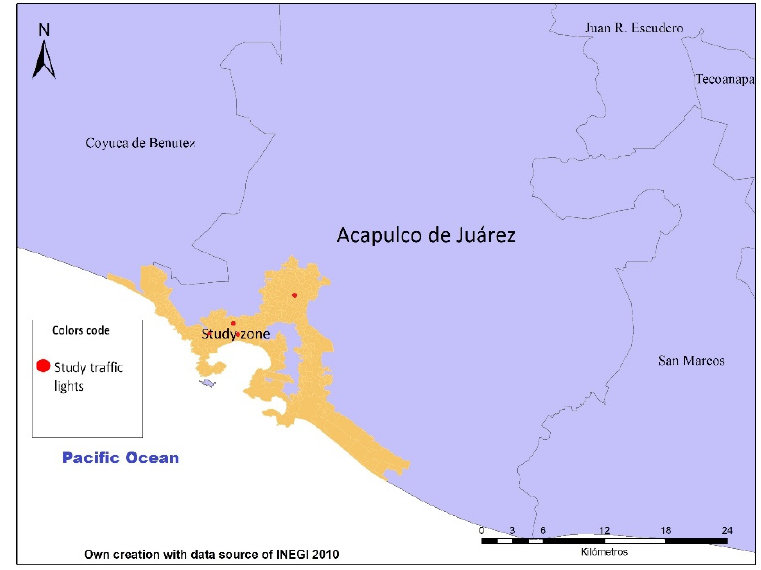
Figure 1. Study area of the metropolitan area in Acapulco.